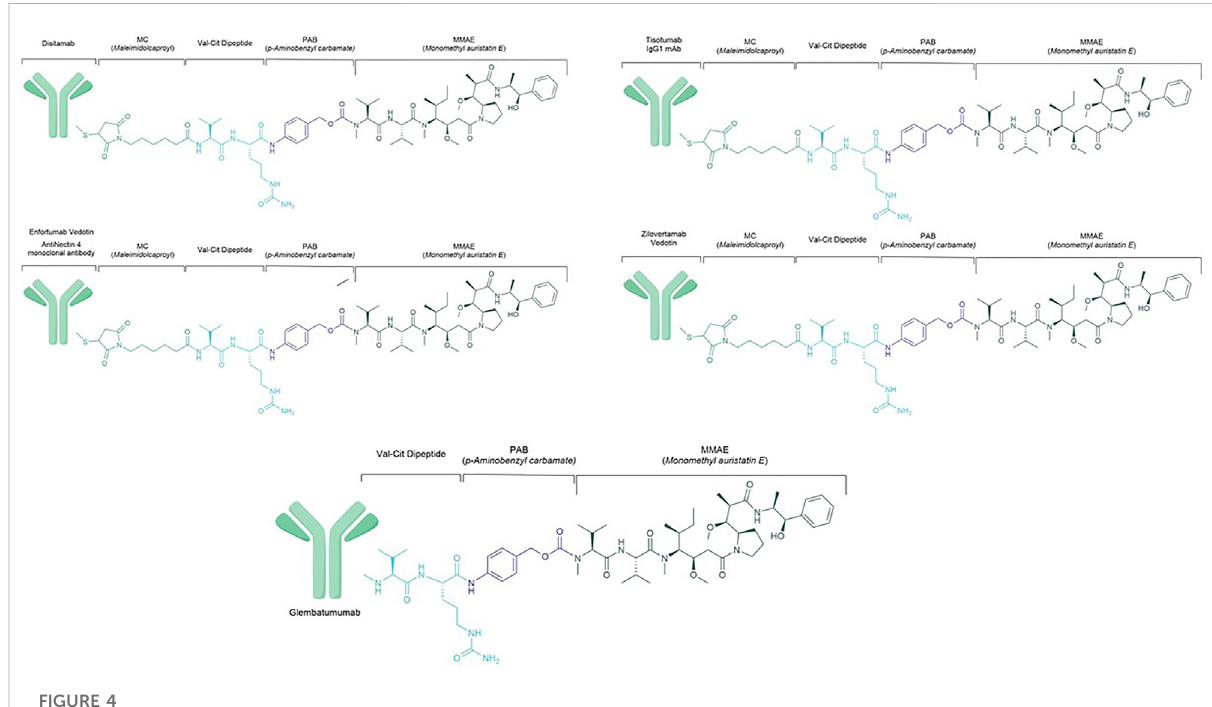
FIGURE 4 Chemical structure of main monomethyl auristatin E